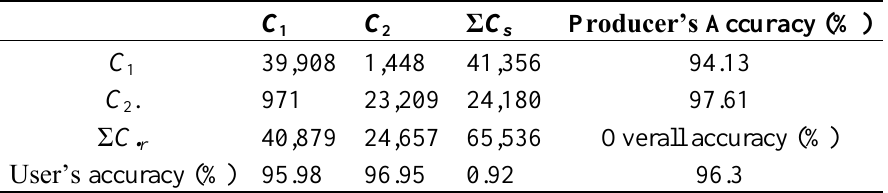
Table 3. Error matrix and statistical measurements.